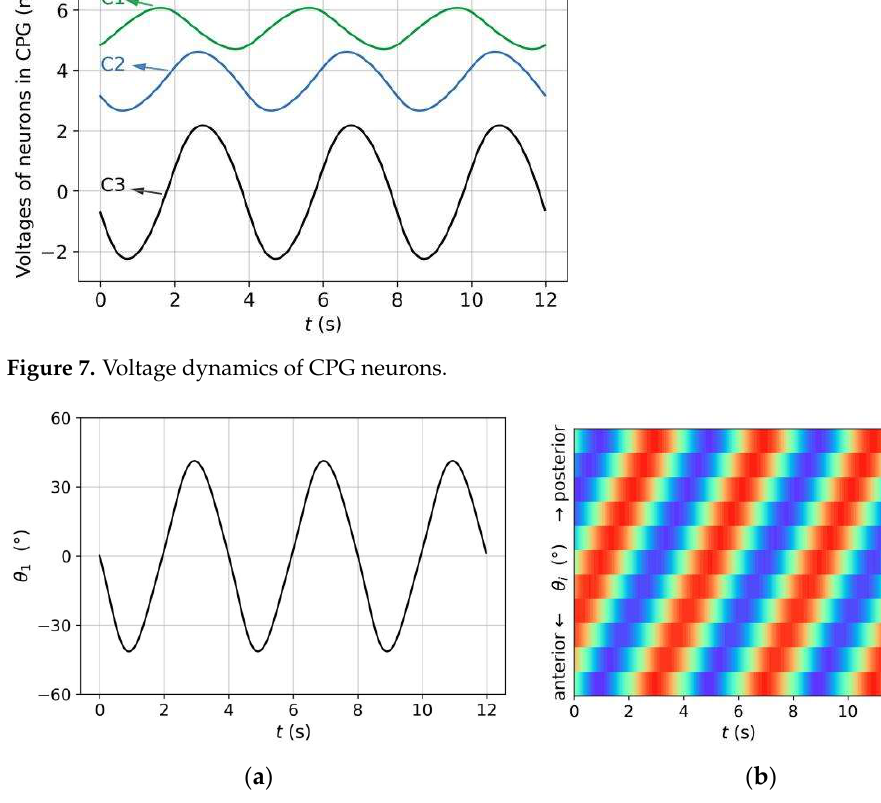
Figure 8. ( a ) periodic changes in Joint-1 angle; and ( b ) kymogram depicting changes in all joint angles over time.